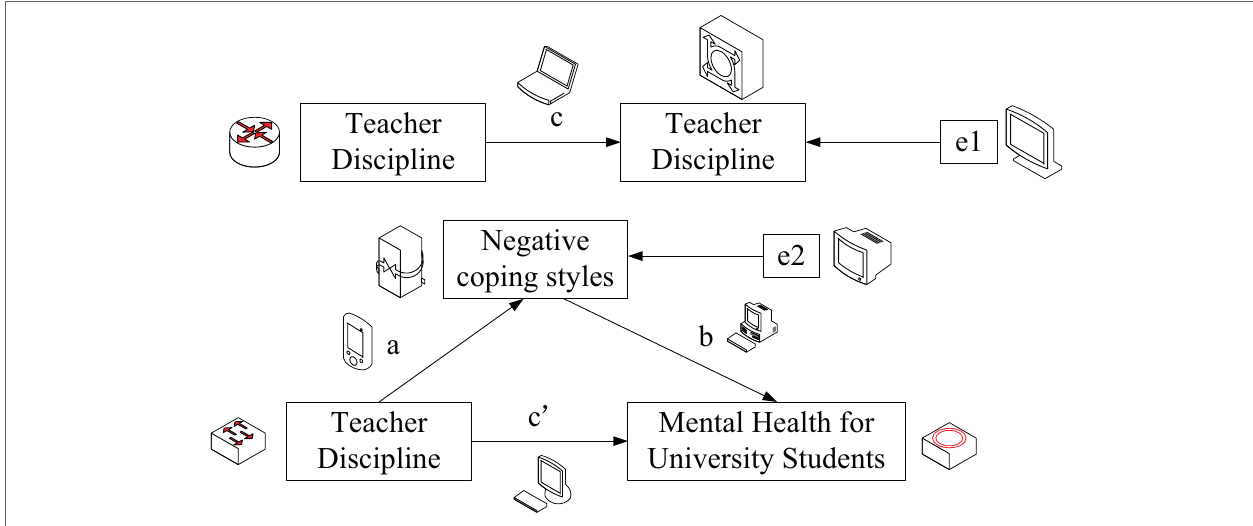
FIGURE 3 | Pathways mediated by negative coping styles between teacher punishment and student mental health.